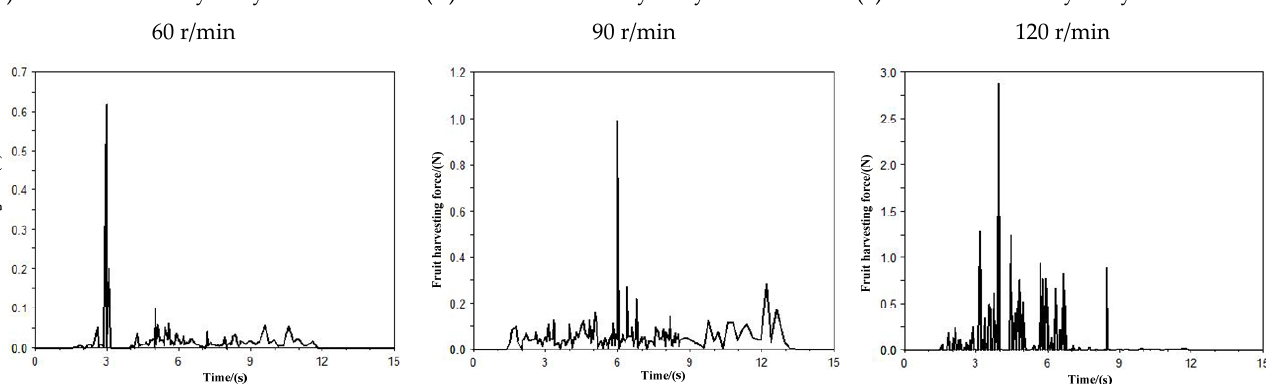
Figure 16. Analysis of the influence of rotational velocity on the harvesting force.